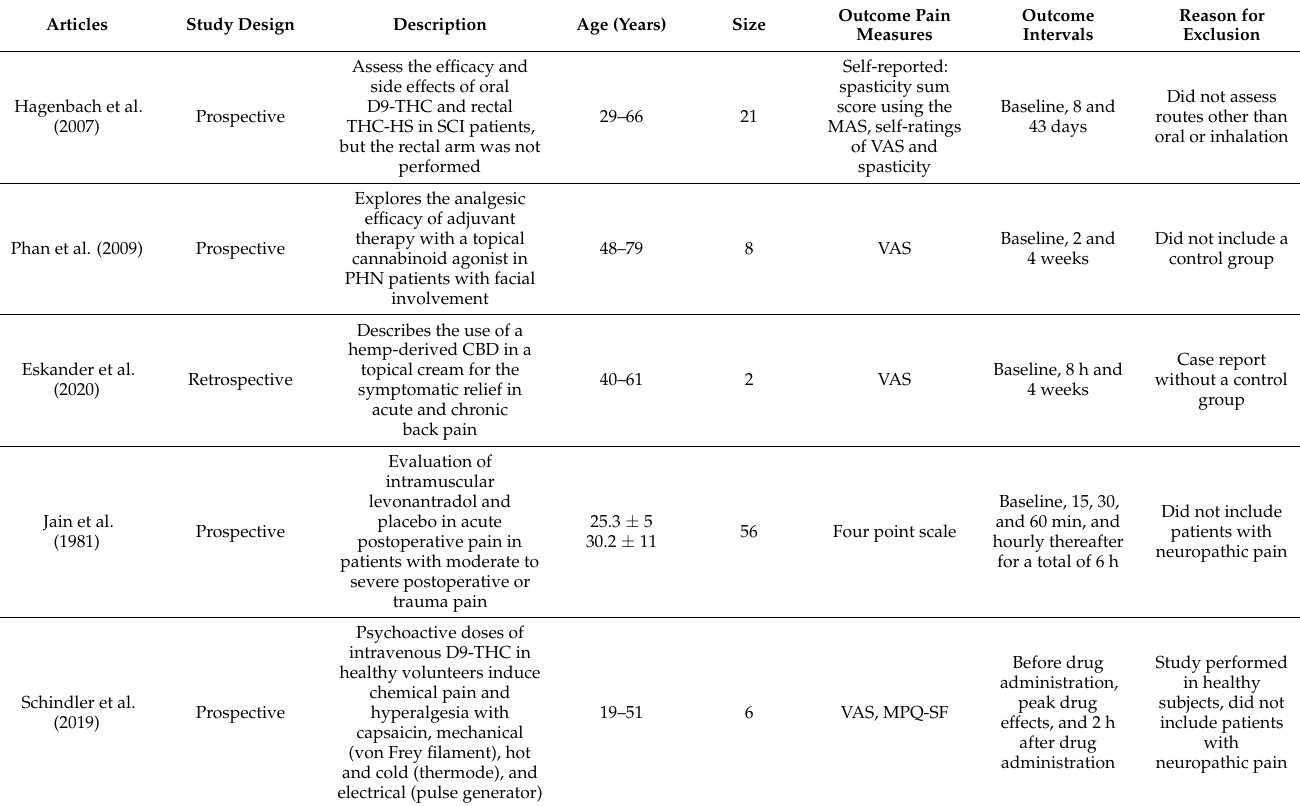
Table 2. Detailed description of excluded studies after full text